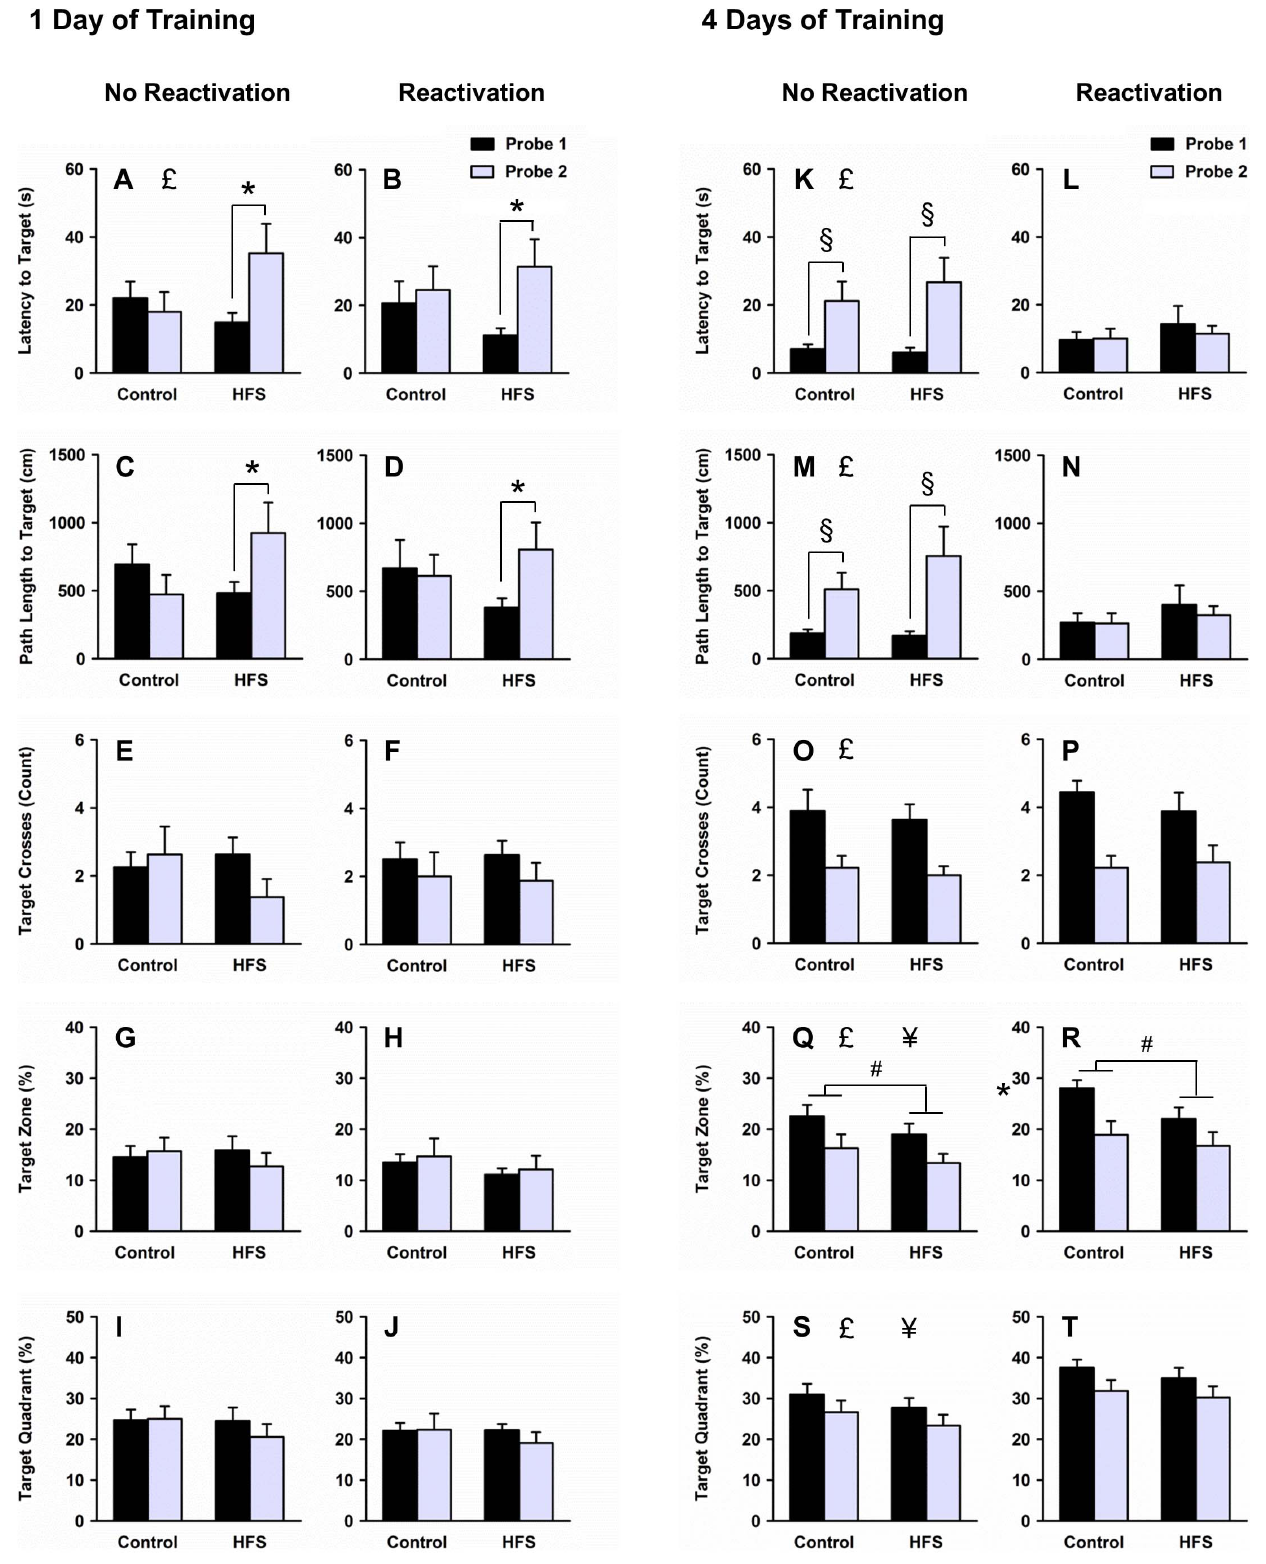
Figure 5. Probe tests. Among rats that underwent 1 day of training, rats in the HFS group exhibited a significant increase in latency ( AB ) and path length ( CD ) to the target location across consecutive probe tests, whereas rats in the control group exhibited no change across probe tests. HFS did not affect number of target crosses ( EF ), time spent in the target zone ( GH ), or time spent in the target quadrant ( IJ ). Among rats that underwent 4 days of training, HFS rats spent less time in the target zone than control rats during both probe tests ( QR ). Also, rats in the reactivation group